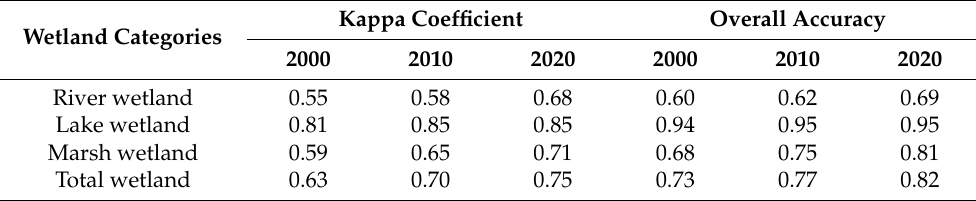
Figure 3. Spatial distribution of the wetlands in the YRSNP from 2000 to 2020. Table 5. Classification accuracy of wetlands in the YRSNP.